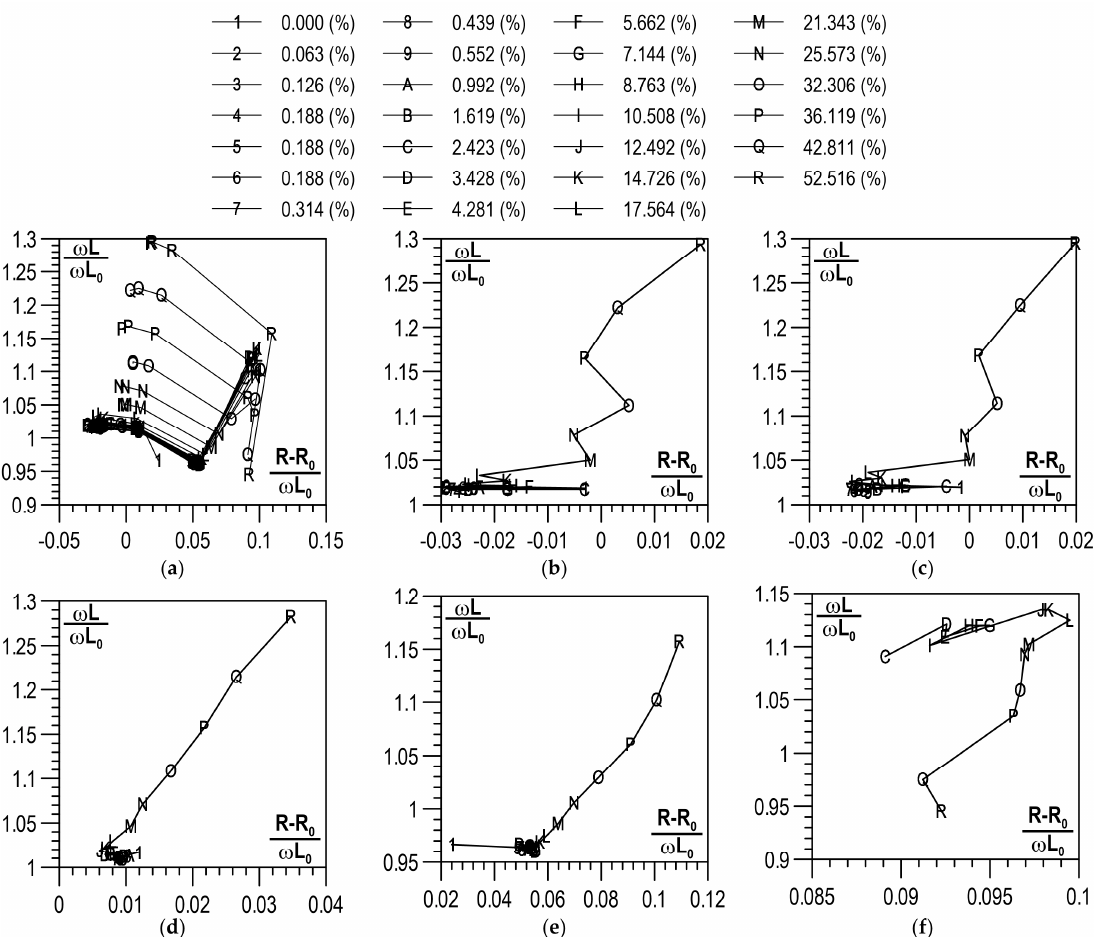
Figure 10. Results obtained from the analysis of the LCR measurements: ( a ) curves of normalised impedance components for different states of plastic deformation; distribution of normalised impedance components for: ( b ) f = 0.1 kHz; ( c ) f = 0.12 kHz; ( d ) f = 1 kHz; ( e ) f = 10 kHz; ( f ) f = 100 kHz.